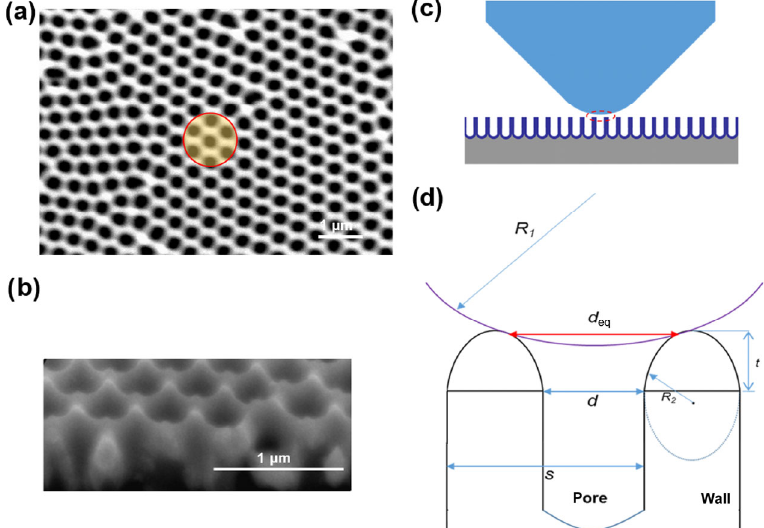
Fig. 5 Unit contact model of metallic porous nanostructures. (a) SEM top-view image of metallic porous nanostructures with highlighted projected area of the conical tip on the metallic porous nanostructures; (b) SEM tilted-view image of metallic porous nanostructures; (c) schematic illustration of contact between the conical tip and metallic porous nanostructure; (d) detailed illustration of the unit contact model between the conical tip and metallic porous